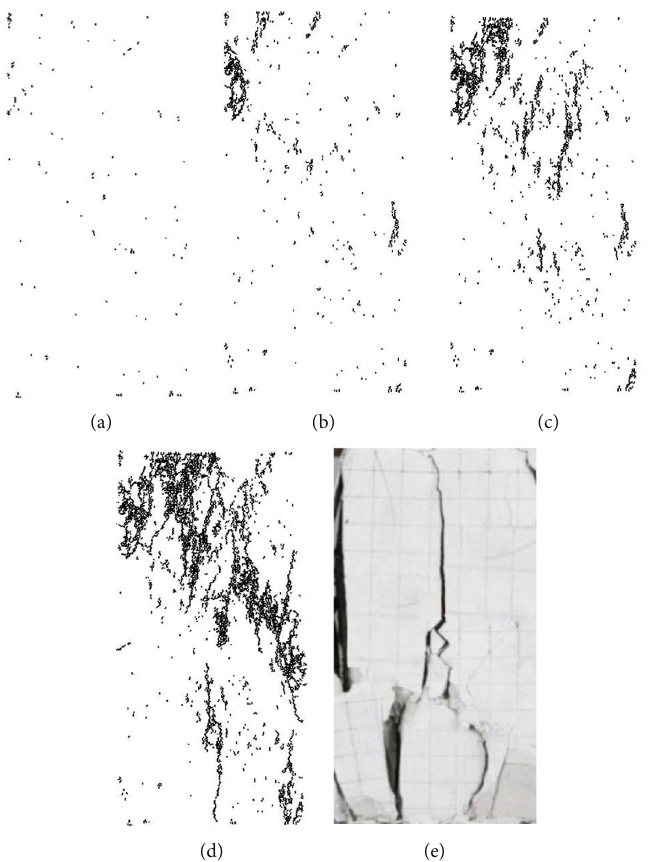
Figure 9: The process of crack initiation and development at the bend number of 3. (a) ε = 0 : 0067 . (b) ε = 0 : 0122 . (c) ε = 0 : 0183 . (d) ε = 0 : 235 . (e) Instable